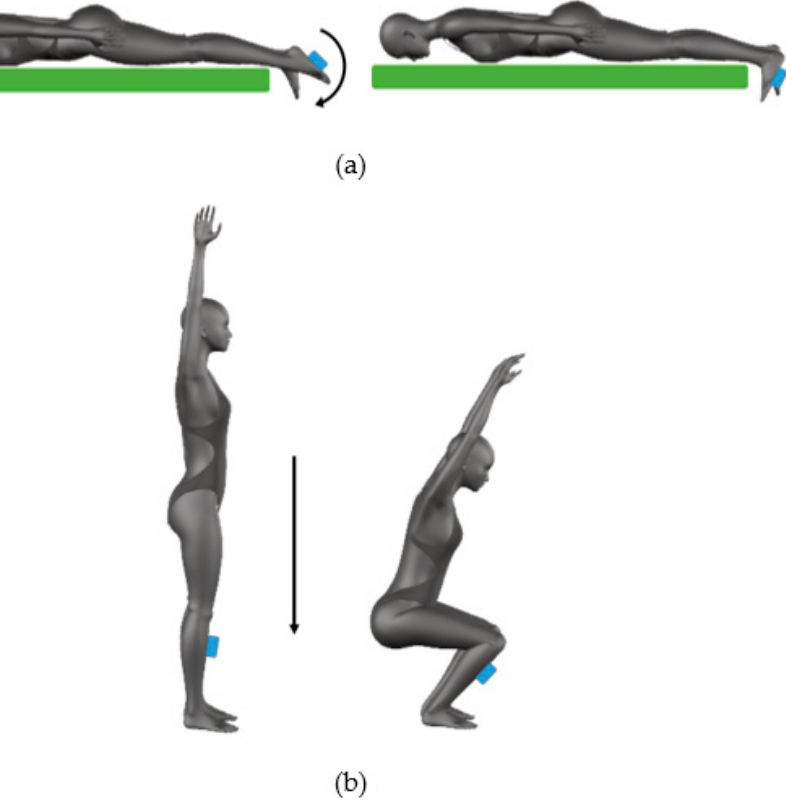
Figure 4. Mobility of ankle: positioning of the sensor and movement direction for flexion ( a ) and squat ( b ) task.